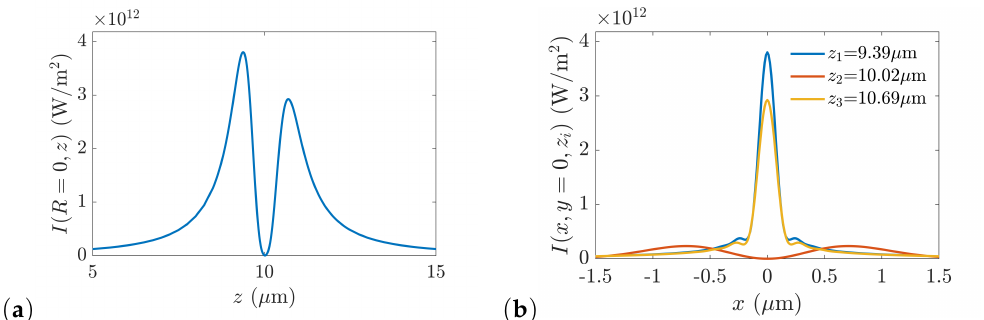
Figure 7. ( a ) evolution of the intensity in the beam axis with propagation distance after the focus of a lens and ( b ) intensity profile at different propagation distances for a source with m = 1, λ = 632.8 nm, δ c = 0.1 mm and w 0 = 0.5 mm. Other parameters are f = 5 mm, s 0 = 2.50 m, and I 0 = 1 W/mm 2